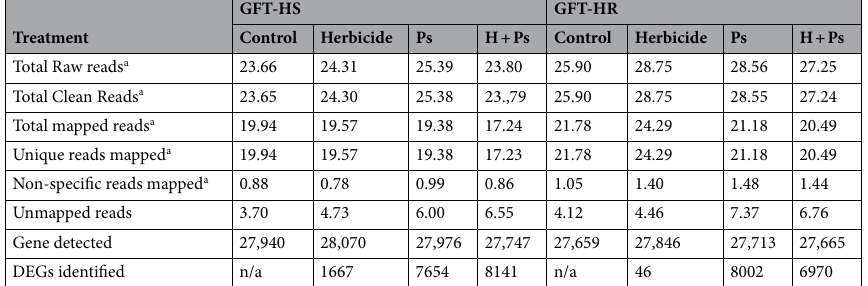
Table 3. Statistics of RNA-seq for herbicide-sensitive (HS) and—resistant (HR) biotypes of green foxtail (GFT) treated with sethoxydim herbicide (0.1 × recommended rate), Pyricularia setariae (Ps), and herbicide plus Ps (H + Ps). a Reads = × 1,000,000.